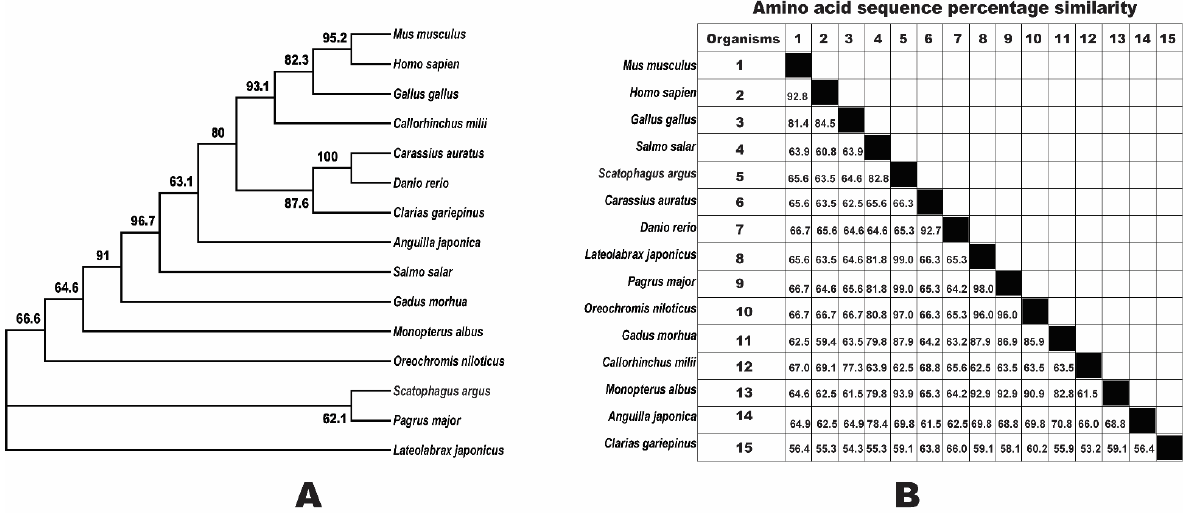
Figure 2. ( A ) Phylogenetic tree spotted scat Npy peptide with Npy of Mus musculus (NP_075945.1),